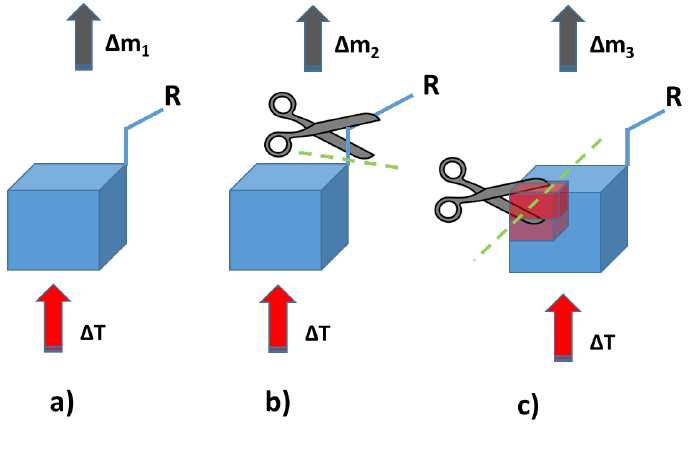
Figure 3. Suggested mechanisms of thermal changes taking place in the synthesized compounds. Route ( a ) — sublimation of compounds; route ( b ) — fragmentation of attached functional groups; route ( c ) — fragmentation of the cube core.